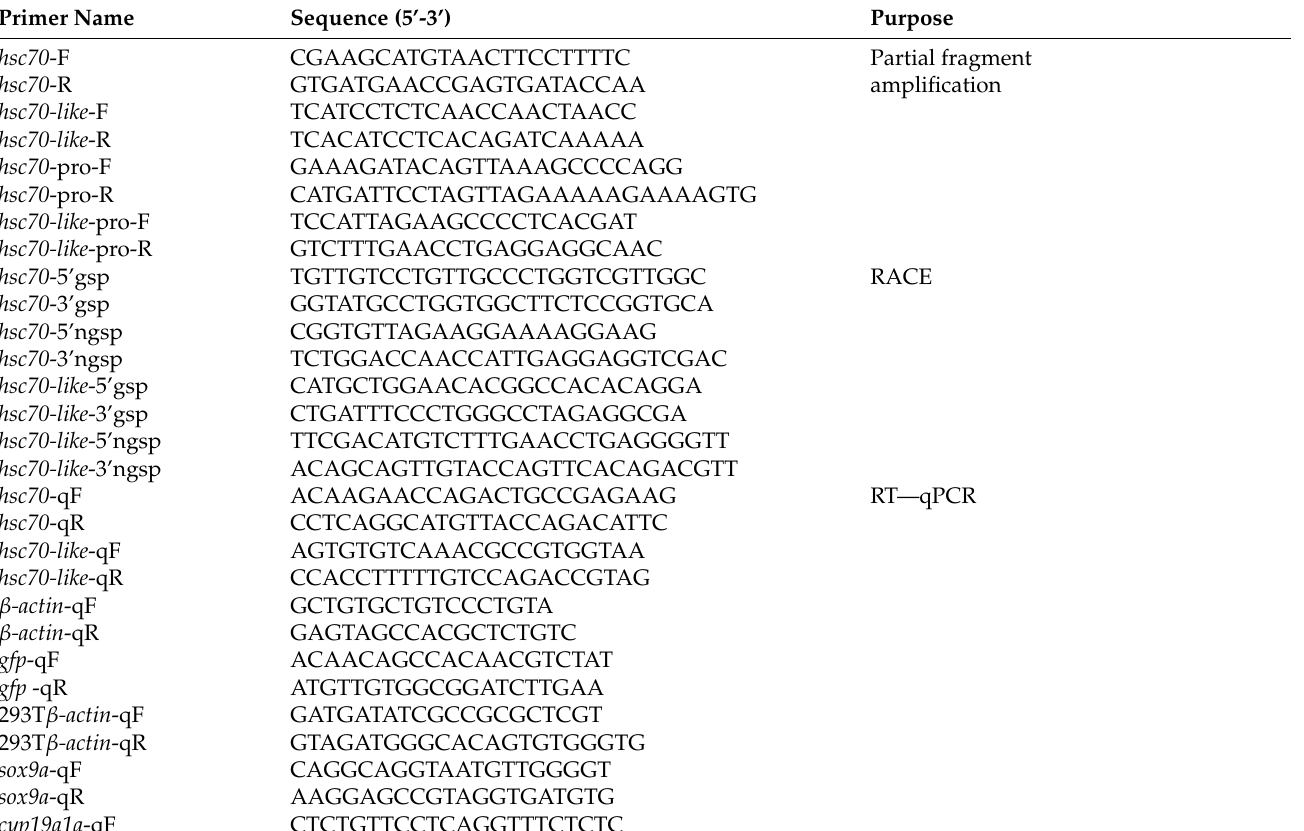
Table 1. Primers used in this